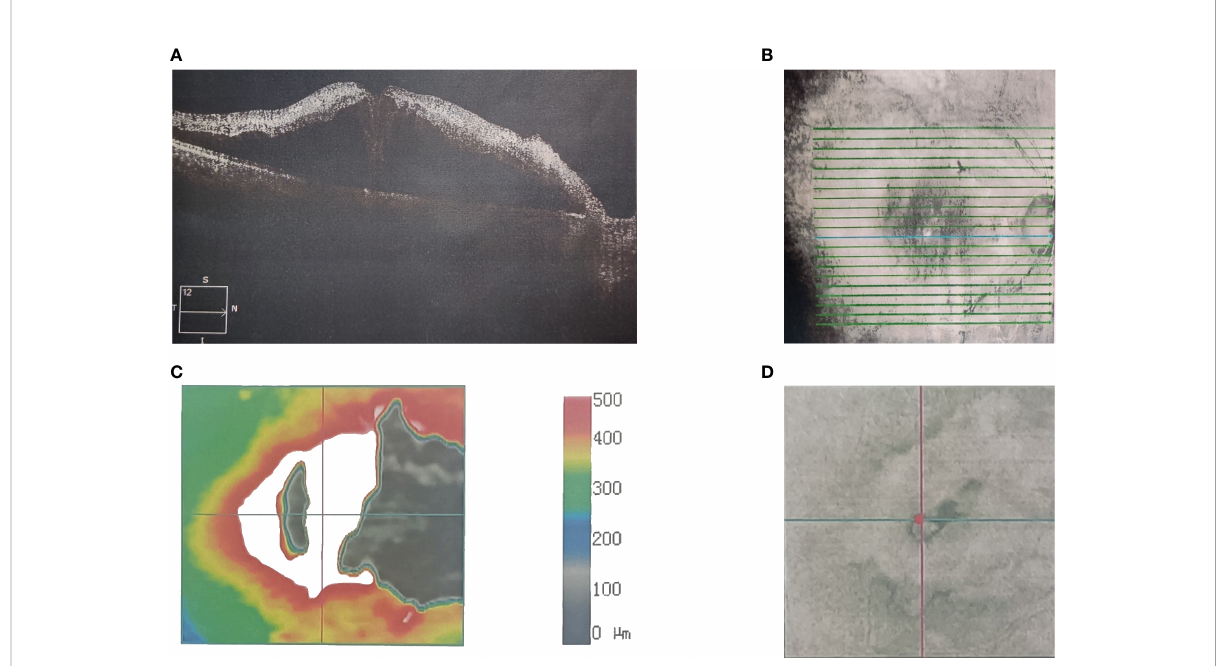
FIGURE 1 A 56-year-old Asian male with lung cancer and visual acuities (right 20/40). Optical coherence tomography scanning shows the (A) microstructure of the macular region of the right eye. (B) Scan range of the macular area of the right eye. (C) Topographic map of the macular region of the right eye. (D) Scan coordinates for the macular region of the right